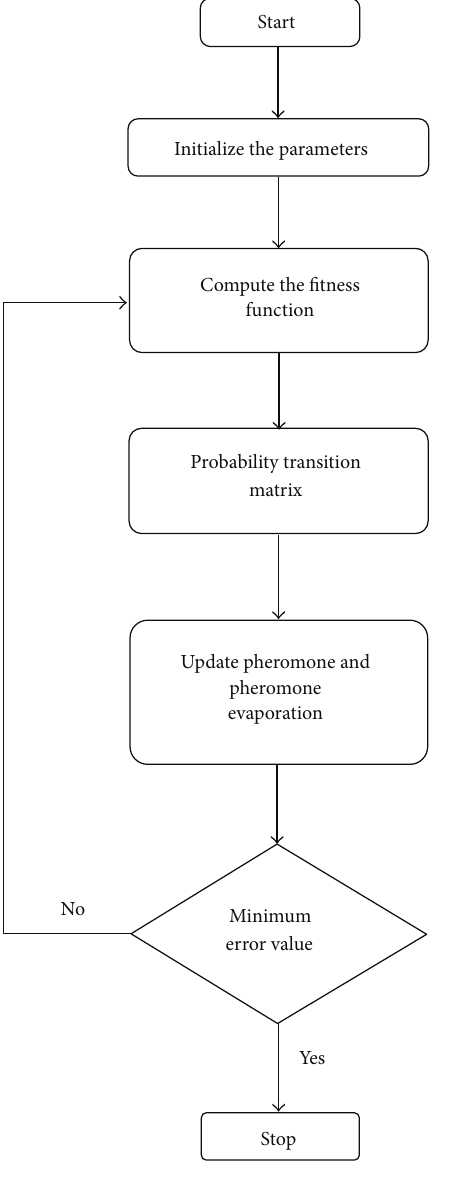
Figure 2: Flowchart for mathematical modeling with ant colony